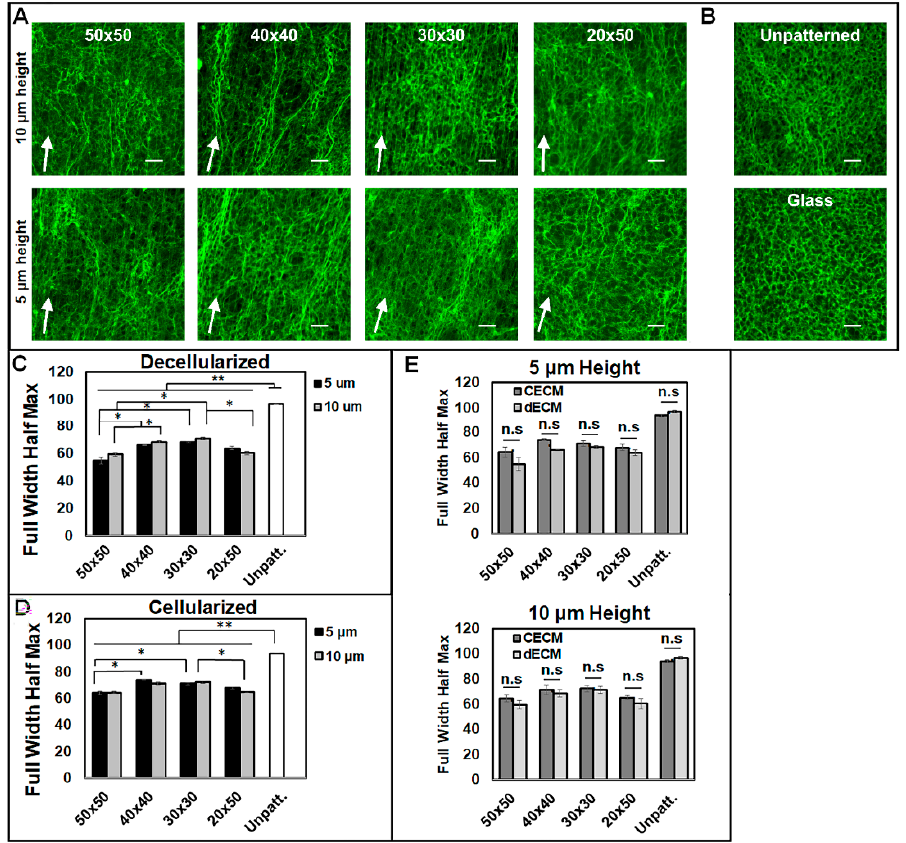
Figure 5. Decellularized, cell-assembled extracellular matrix (ECM) on ( A ) micropatterned PDMS for both pattern heights. ( B ) Decellularized, cell-assembled ECM on unpatterned PDMS (top) and glass coverslip (bottom). White arrows indicate pattern directions. Scale bars = 100 µ m. Fibronectin (FN) fibrils visualized with R457 rabbit anti-fibronectin polyclonal antiserum ( C ) Full width half maximum calculations for decellularized matrices. ( D ) Full width half maximum calculations for matrices prior to decellularization. ( E ) E ff ect of pattern height on the di ff erential alignment of deposited FN matrices for both decellularized and non-decellularized conditions. n = 3 unique images per condition. Data are presented as mean ± SE, where * p ≤ 0.05, ** p ≤